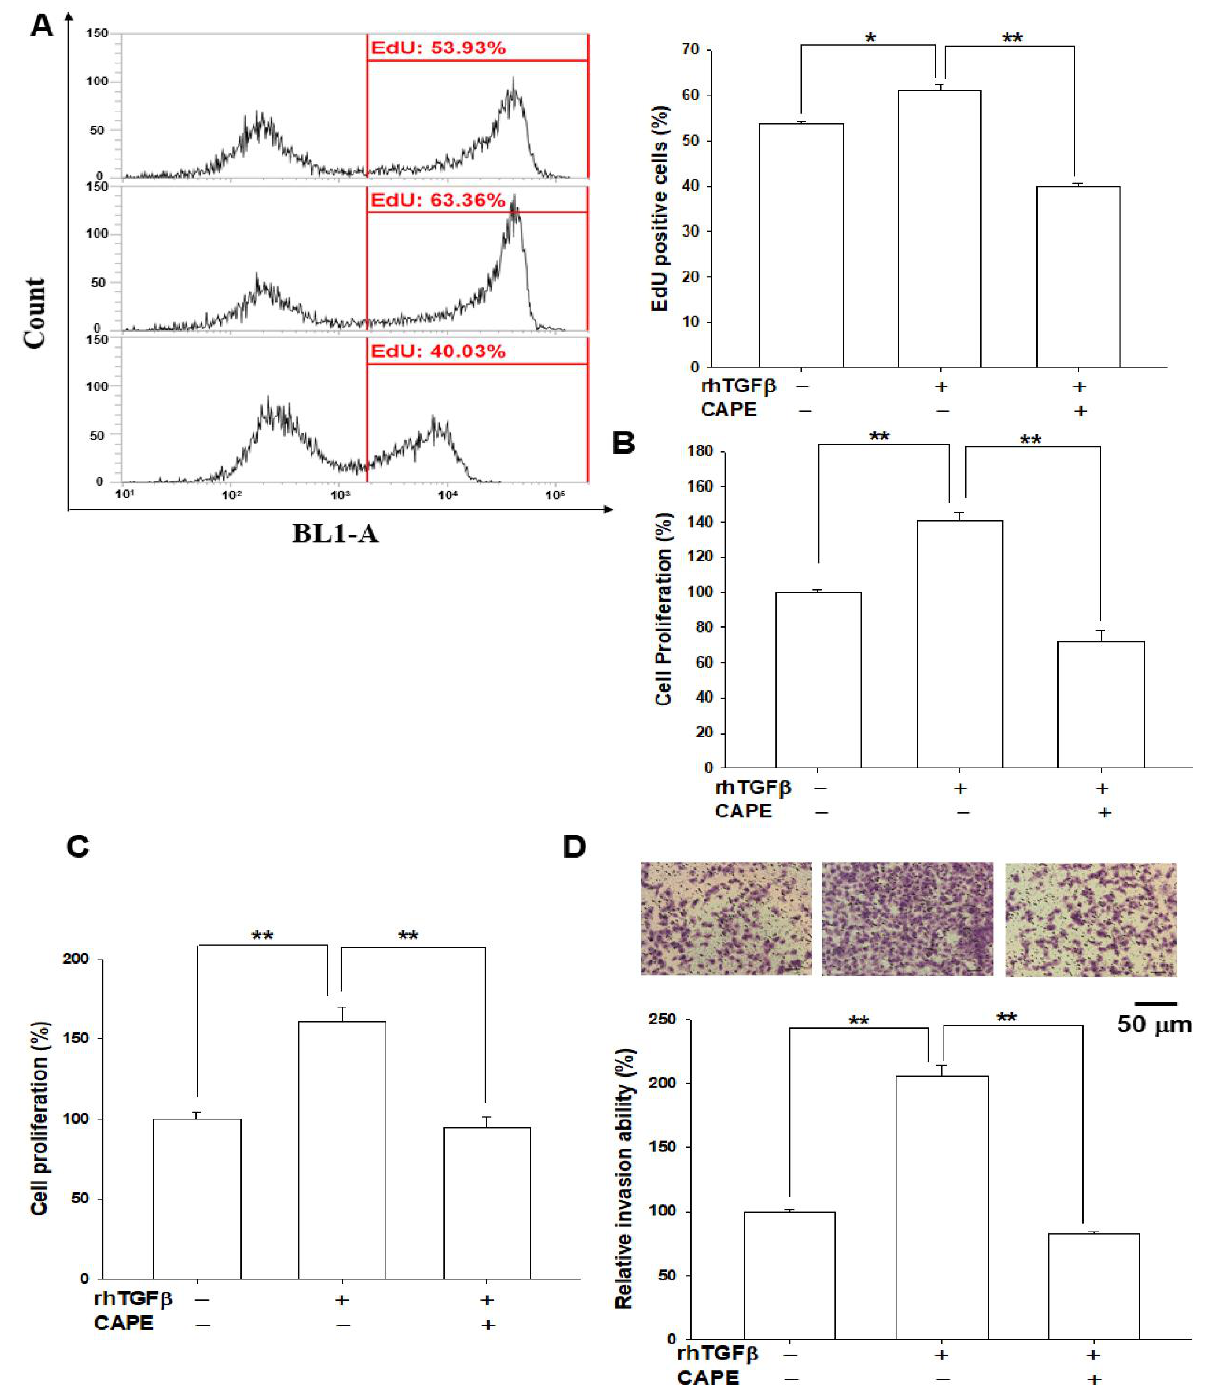
Figure 6. CAPE blocks the enhancement of TGF β on cell proliferation and invasion. Cell proliferation of T24 cells after treated with rhTGF β (10 ng/mL) and/or CAPE (20 µ M) as indicated for 48 h was determined by EdU (( A ), n = 4), WST-1 (( B ), n = 8), and CyQUANT (( C ), n = 8) assays. The data were presented as the mean percentage ( ± S.E.) compared with the control group. ( D ) T24 cells were treated with rhTGF β (10 ng/mL) or rhTGF β with CAPE (20 µ M) for 24 h and the cell invasive ability was measured by the matrigel invasion assay after 24 h of incubation. The data were presented as the mean percentage ( ± S.E.) compared with the control group ( n = 3). * p < 0.05, ** p < 0.01.